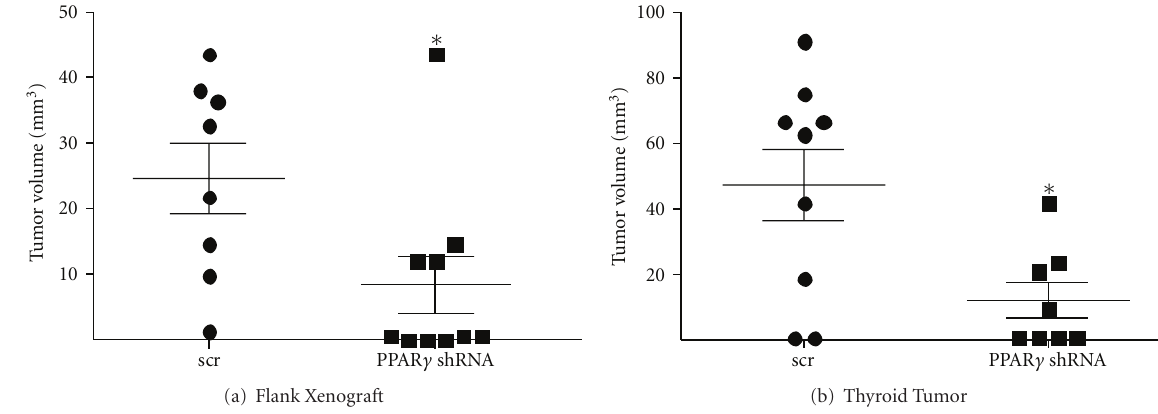
Figure 5: PPAR γ knockdown attenuates both flank and thyroid orthotopic tumor growth of HTh74 anaplastic cancer cells. (a) 5 × 10 6 HTh74 cells stably expressing a scrambled (scr) control ( n = 8) or PPAR γ shRNA ( n = 10) were injected sc into the right flank of an athymic nude mouse. Tumors were monitored visually and harvested after 8 weeks and measured in 3 dimensions with calipers. Final tumor volume was calculated with the following equation: volume (mm 3 ) = L ∗ W ∗ D ∗ 0.523. Mean ± SEM is reported ( ∗ , P = 0 . 023, two-tailed t -test). (b) 0.5 × 10 6 HTh74 cells stably expressing a scrambled (scr) control ( n = 9) or PPAR γ shRNA ( n = 8) were injected into the right thyroid lobe of an athymic nude mouse. Tumors were excised after 8 weeks and measured with calipers as before. The mean tumor volume ± SEM is reported ( ∗ , P = 0 . 049, two-tailed t